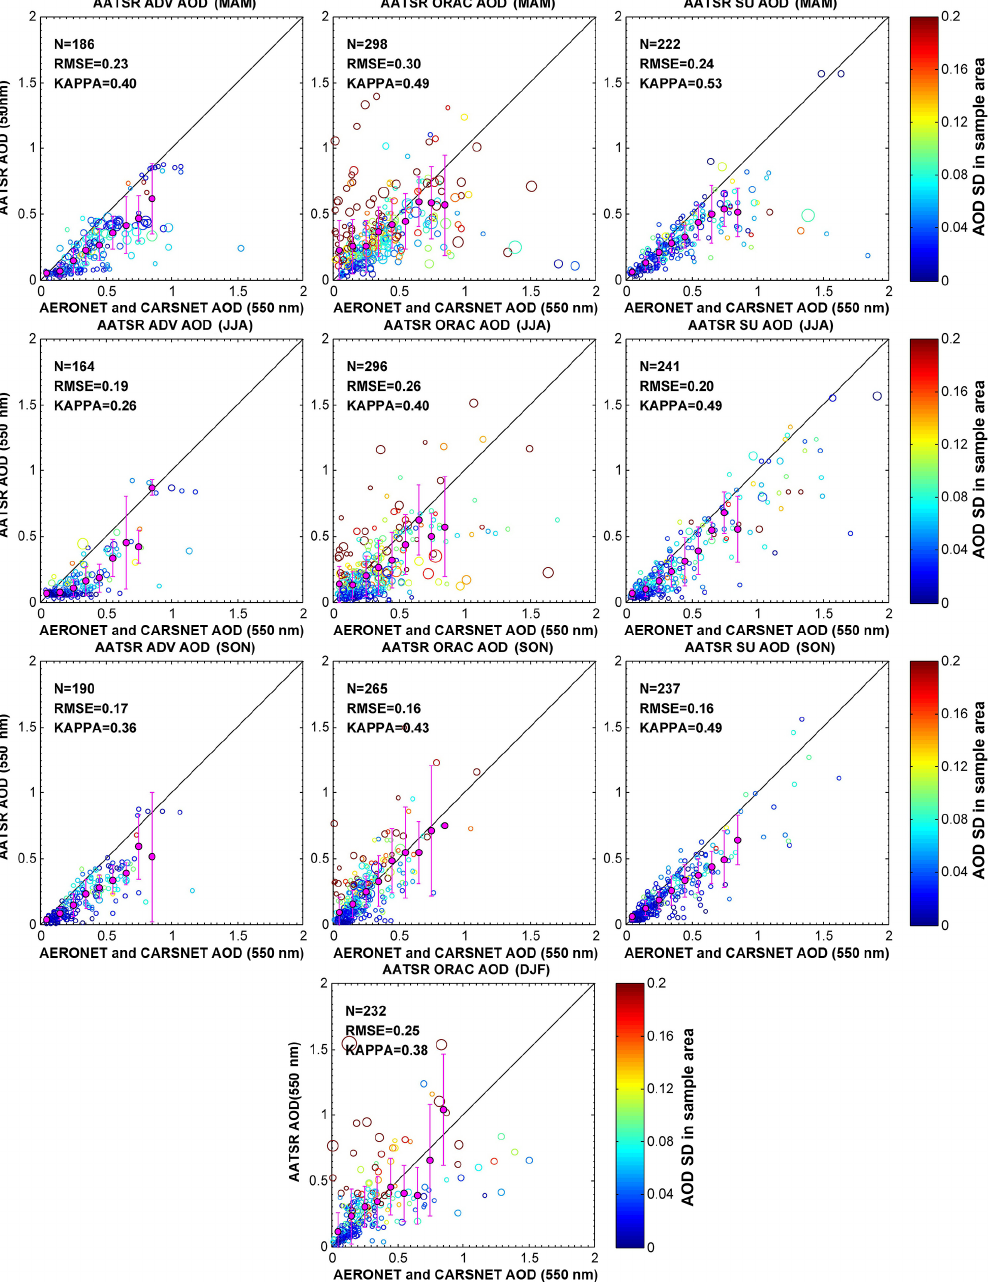
Figure 14. Scatter plots of AATSR ADV, ORAC, and SU L2 AOD products with ground-based data in China in the spring, summer, autumn, and winter time of 2007, 2008, and